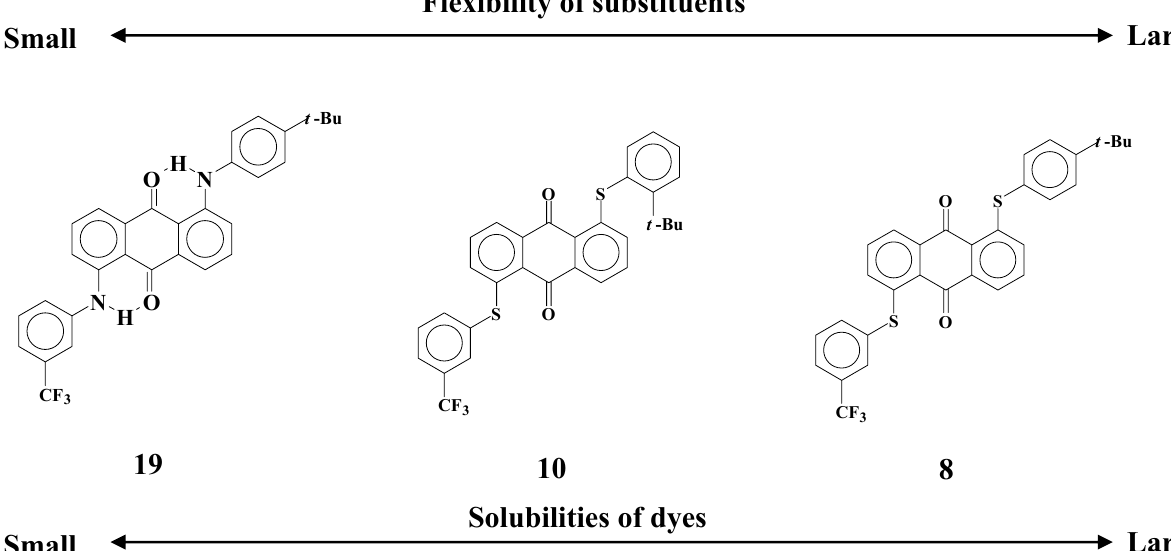
Figure 15. The relationships between flexibility of substituents and solubilities of dyes with analogous molecular structures.